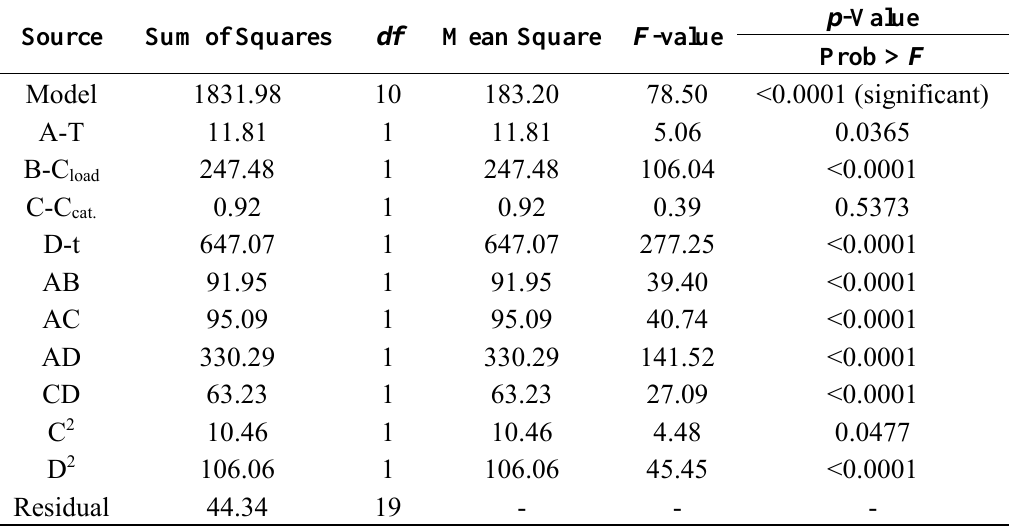
Table 4. Analysis of variance of the preferred model for the yield of